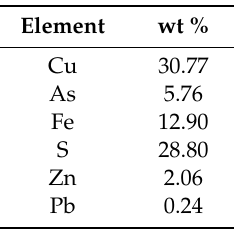
Table 1. Chemical composition of copper ore used in this study, analyzed by Inductively Coupled Plasma-Mass Spectrometry